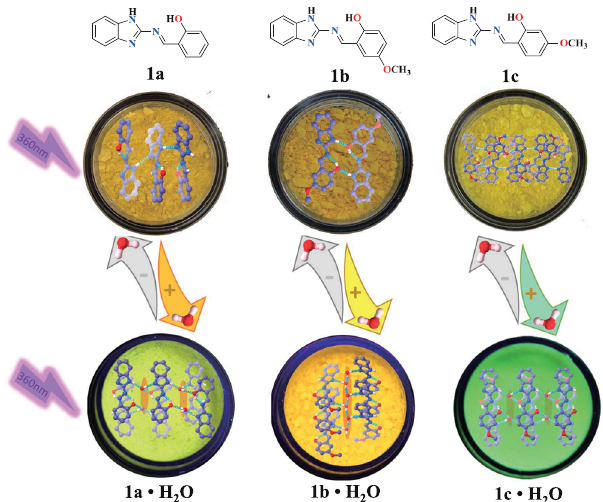
Fig. 1 Schematic of turn-on molecular emission. Water-induced in situ changes in molecular organisation and turn-on of molecular emission for polycrystalline powders of 1a , 1b , and 1c . Intercalation of water molecules into crystal lattices was observed to alter the surroundings of these molecules, leading to structural rearrangement in the crystalline state. These structural changes triggered signi fi cantly enhanced fl uorescence